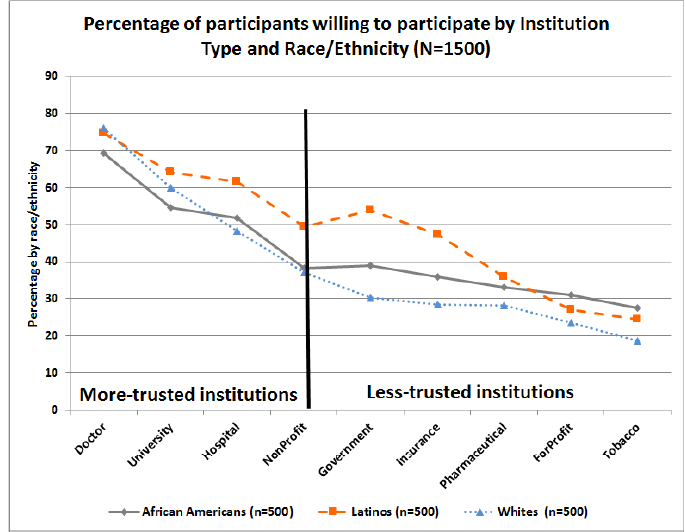
Figure 7. Item-level differences on willingness to participate in research by institution type scale and race/ethnicity.